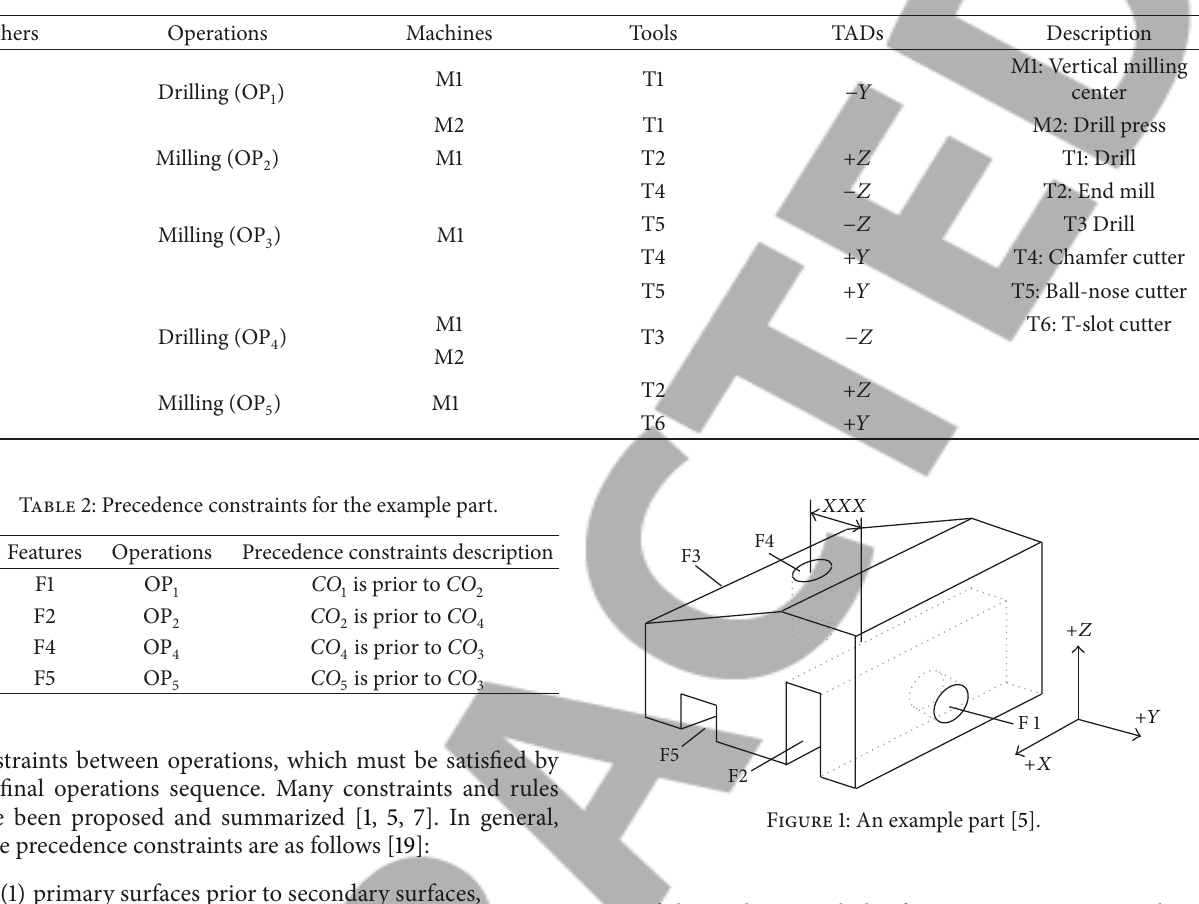
Figure 1: An example part